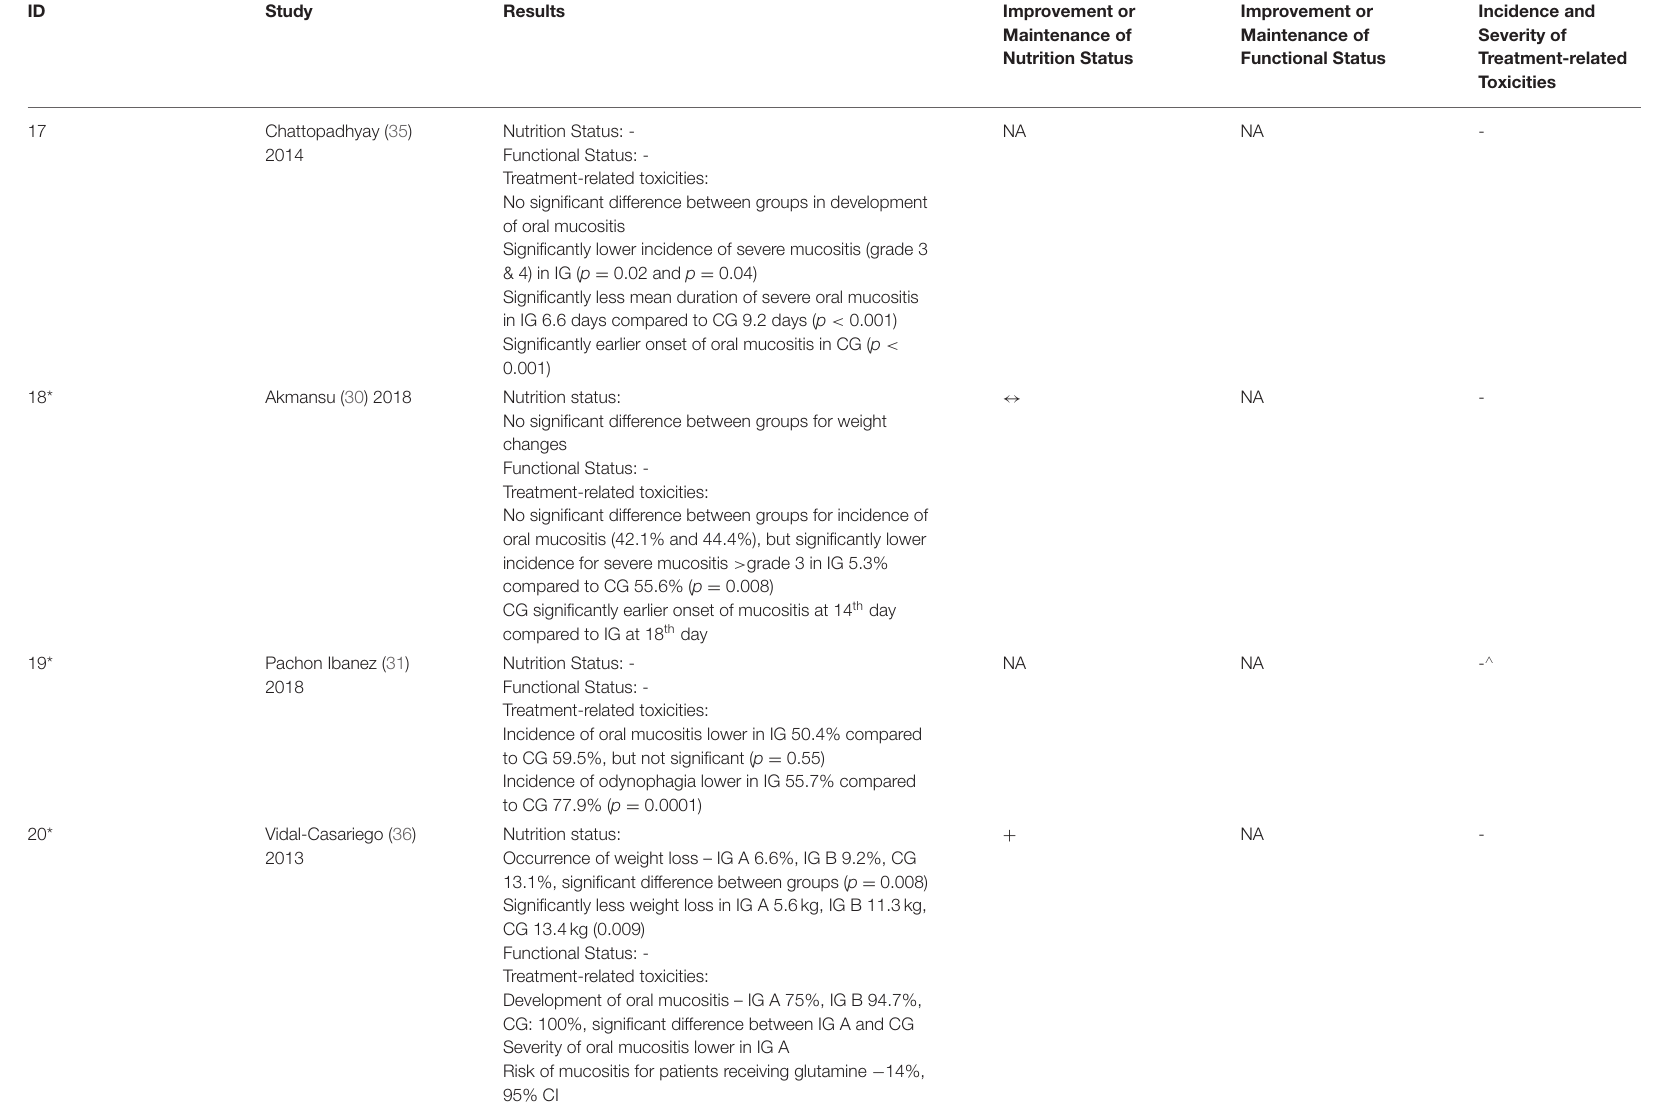
+ Indicates significant improvement or maintenance of nutritional status or functional status in the intervention group compared to control group (p < 0.05). ↔ Indicates non-significant results (p > 0.05). -Indicates significant lower incidence or severity of treatment-related toxicities in the intervention group compared to control group (p < 0.05). NA outcome not being studied or reported ∧ no significant difference for severity and incidence of oral mucositis, but significantly lower incidence and severity of dermatitis in one study and lower incidence of odynophagia in another. * non-RCT